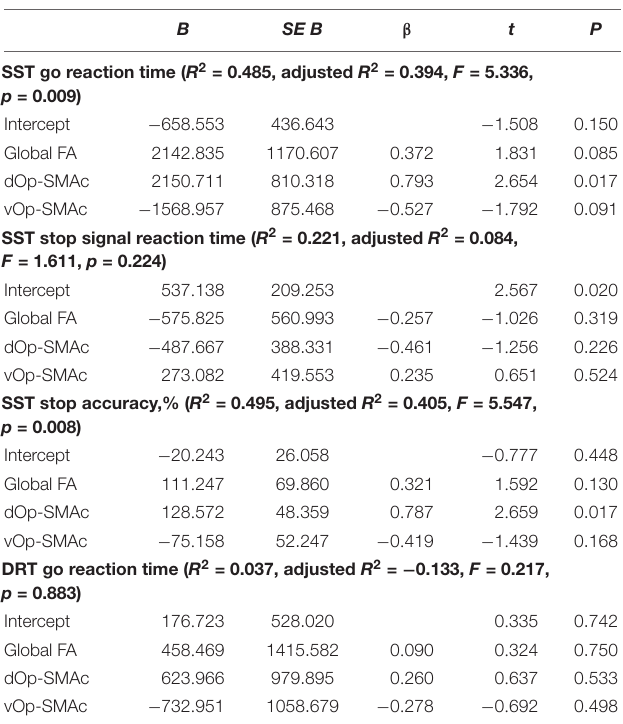
TABLE 2 | Summary of multiple regression analyses ( N =